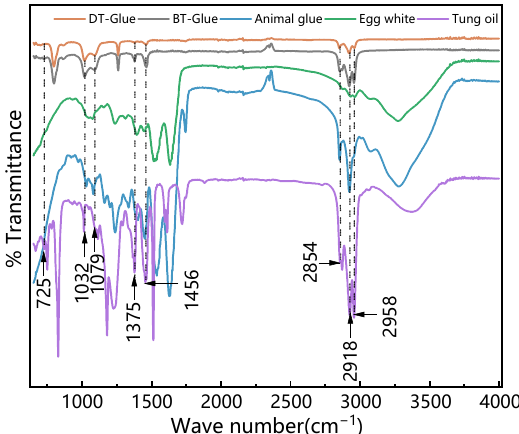
Figure 10. Infrared spectra obtained for binding media samples compared with those for animal glue, egg glue, and Tung oil.